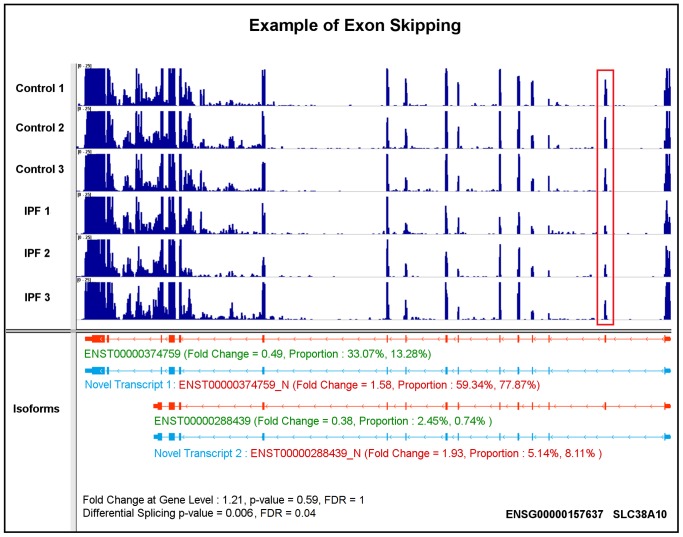
A case study of gene SLC38A10 illustrating the skipping exon splicing mechanism using both annotated and predicted transcripts.